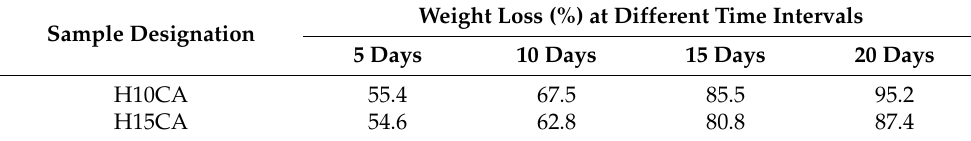
Table 3. Percentage degradation of hydrogels using soil burial method.